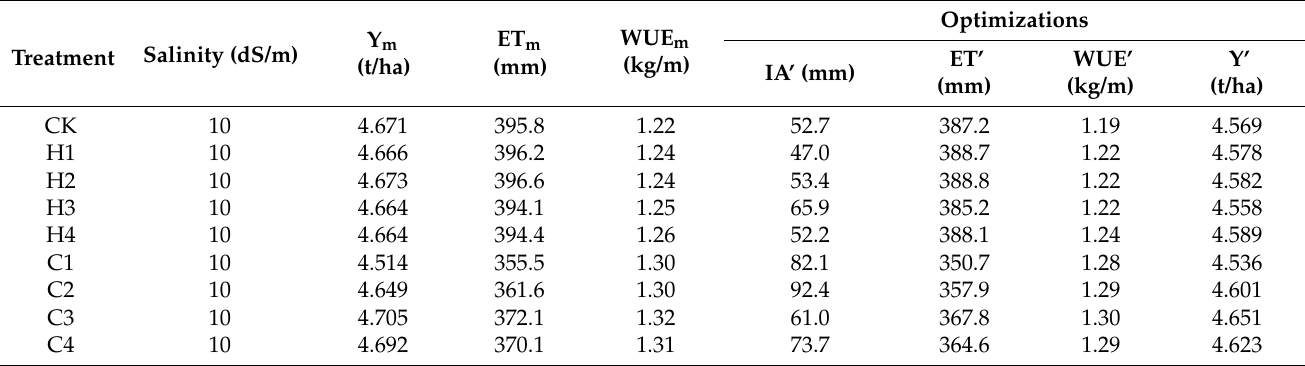
Figure 6. Optimized irrigation amount under the control treatment (CK). Table 6. The optimized levels of irrigation under different soil conditioner